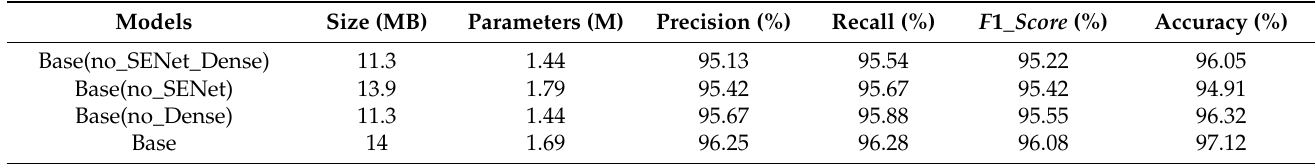
Table 8. The effect of different modules on the model.